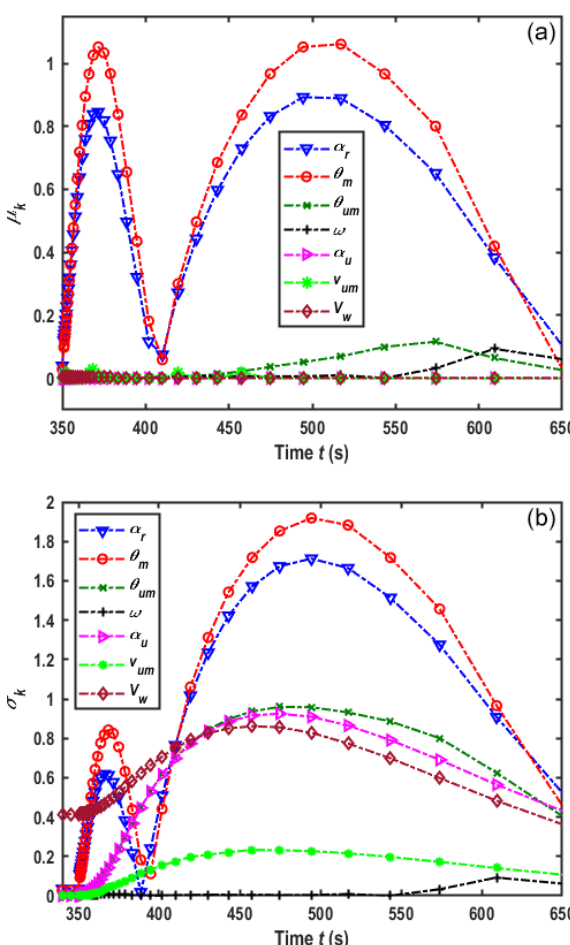
Figure 5. Sensitivity analysis. (a) Variation in µ k with time in the wellbore. (b) Variation in σ k with time in the wellbore.